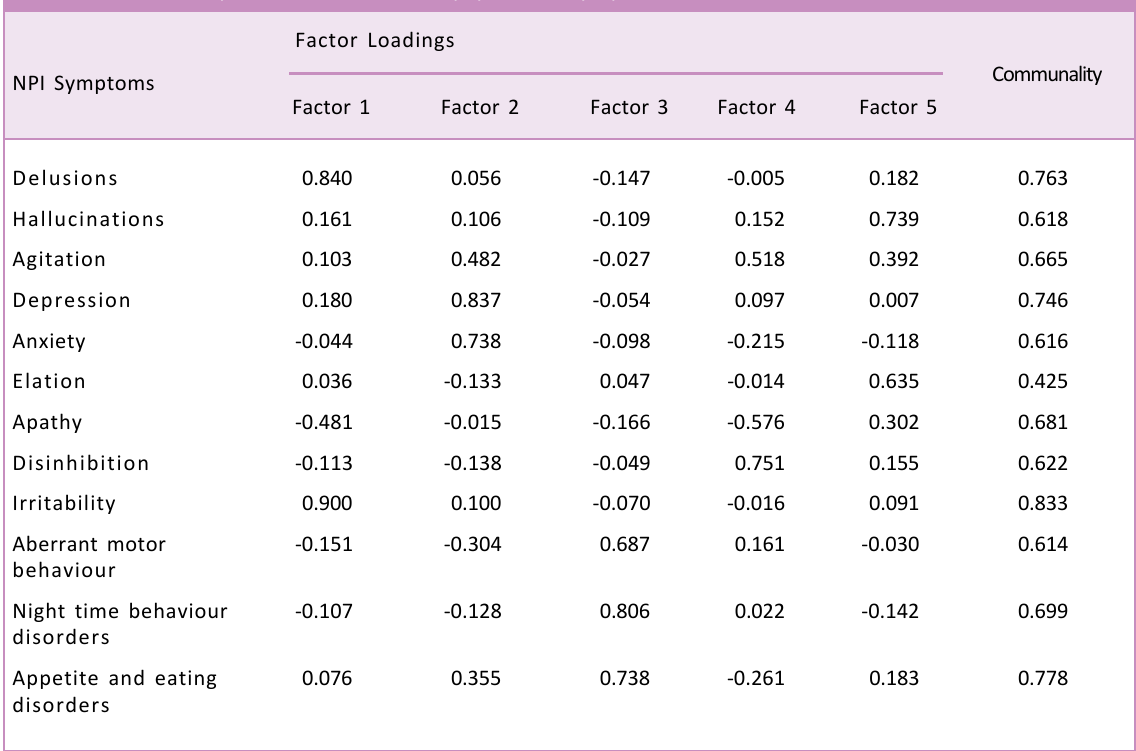
Table 2. Factor analysis solution for neuropsychiatric symptom